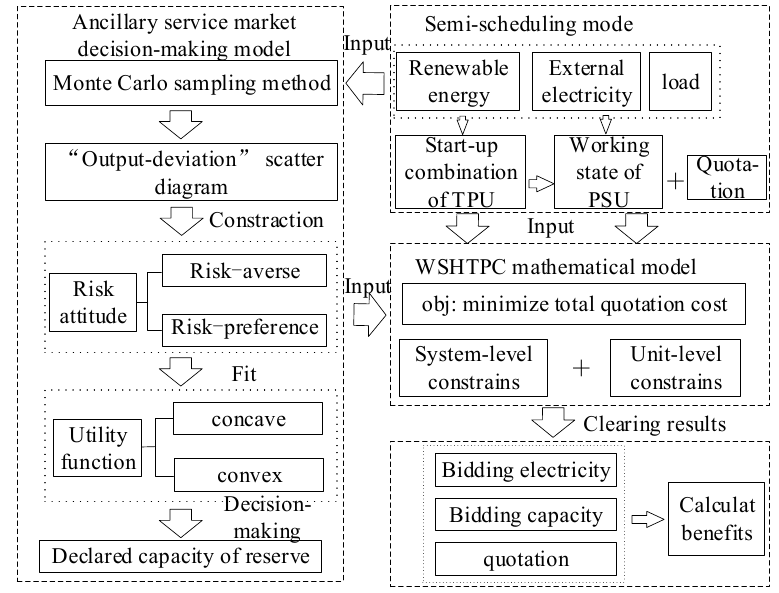
Figure 3. Framework of WSHTPC Model.